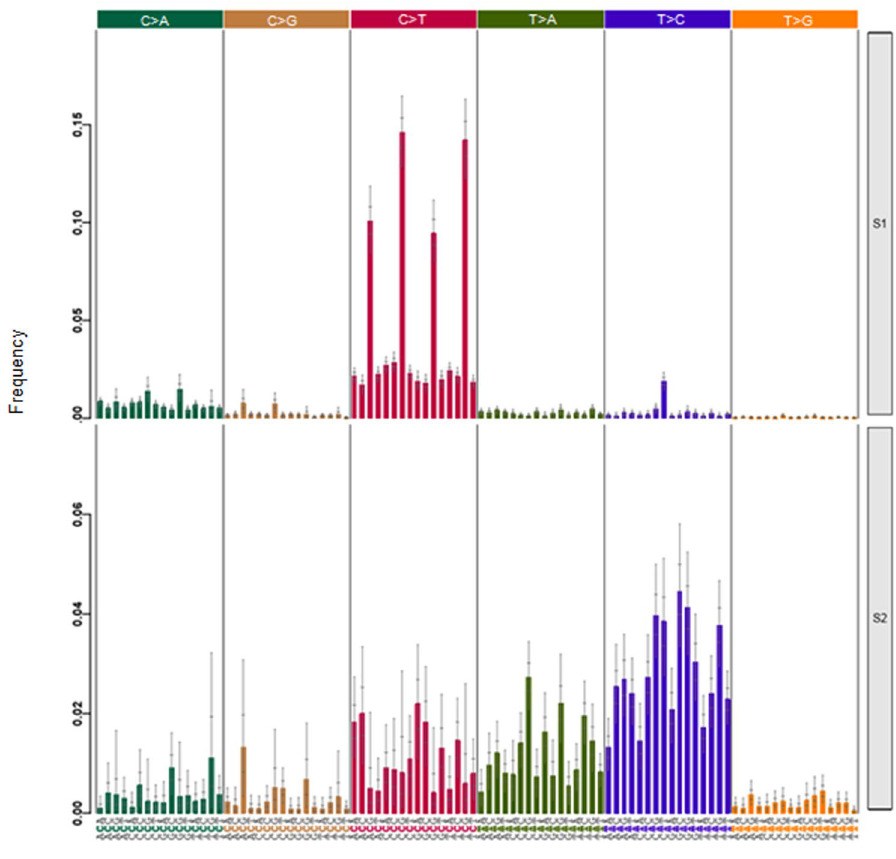
Figure 4. Patterns of the two mutational signatures (S1 and S2) identified in the study cohort. X axes exhibit the 16 mutation types as described in ref. 24.